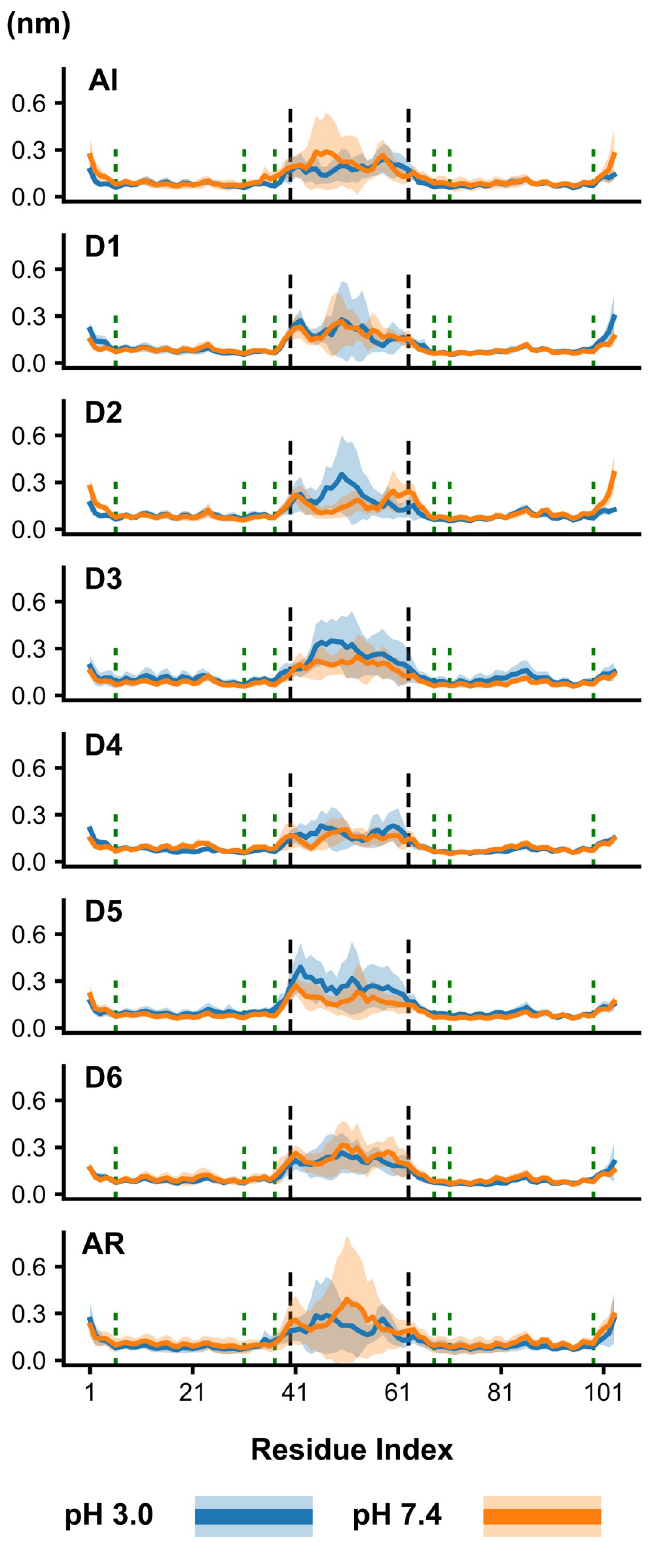
Fig 3. Root-mean-square fluctuation over the last 10 ns of simulations. Colored lines represent pH 3.0 (blue) and pH 7.4 (orange). Data are presented as combined average of both monomeric units and the three replicates ± standard